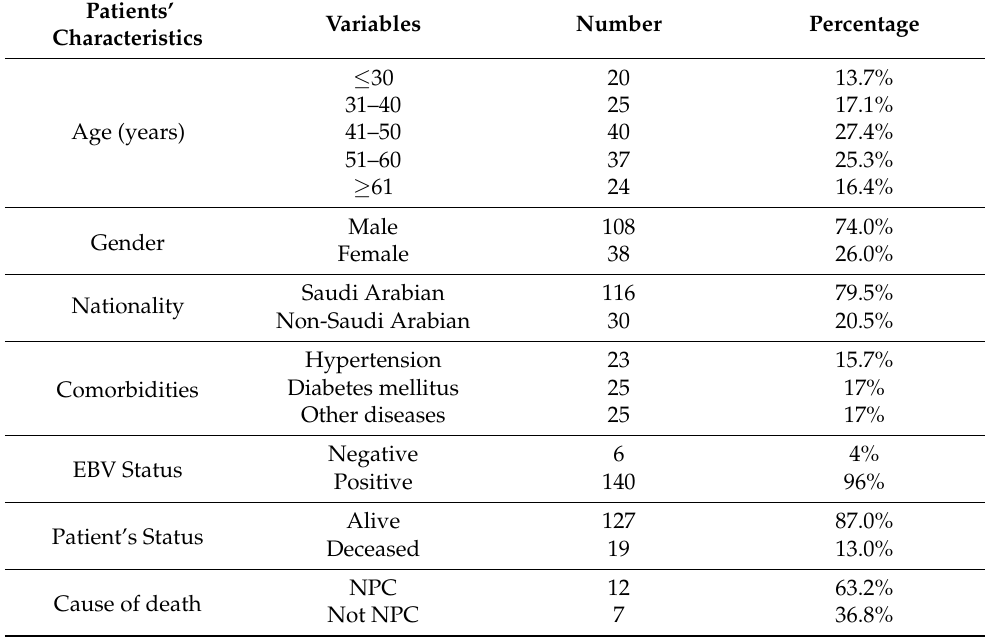
Table 1. Patients’ demographic information and medical